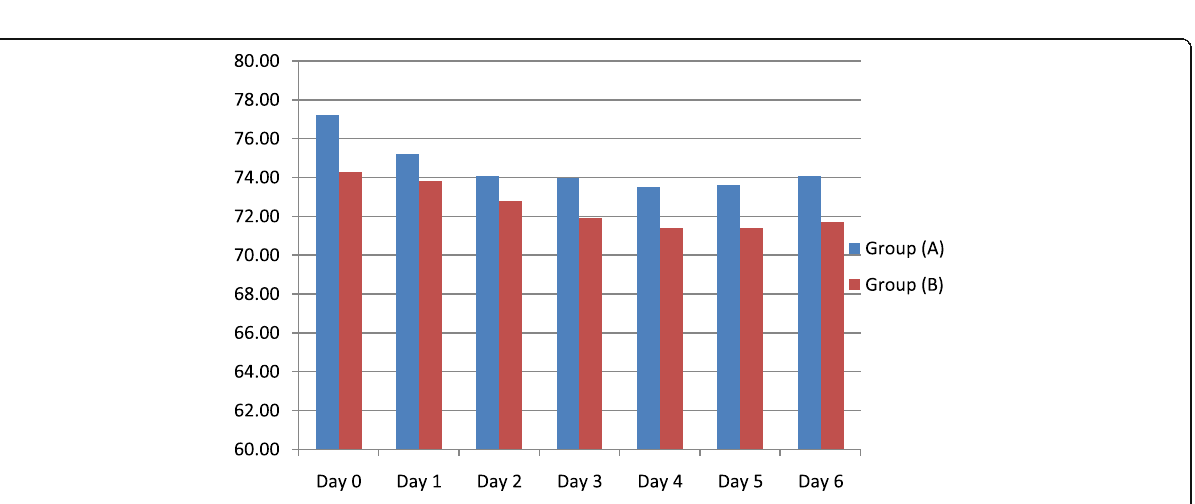
Fig. 3 Bar chart showing the comparison between group A (control) and group B (esmolol) according to CVP